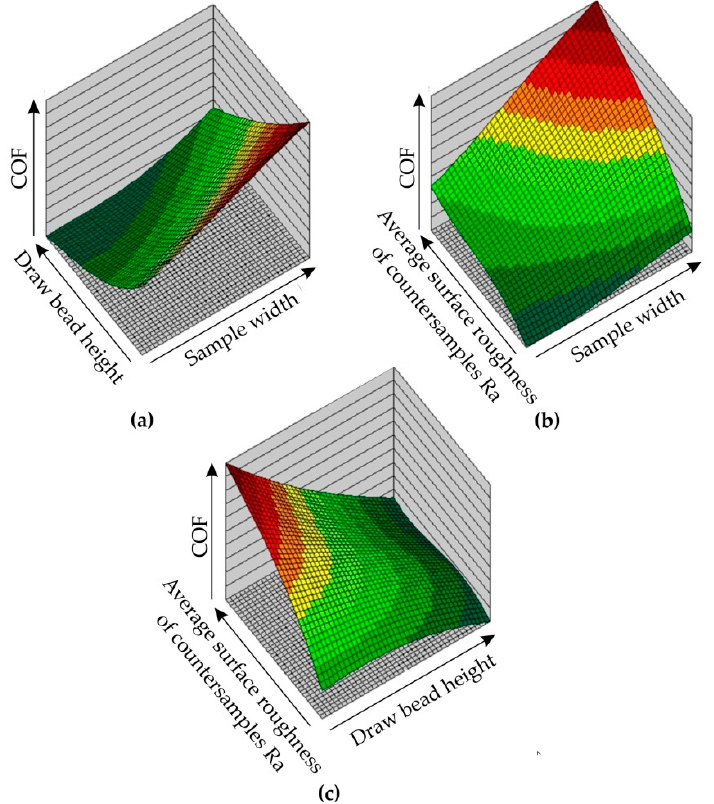
Figure 27. Response surfaces of 5:5-8-1:1 ANN showing the effect of ( a ) sample width and drawbead height, ( b ) sample width and average surface roughness of countersamples Ra, and ( c ) drawbead height and average surface roughness of countersamples Ra on the value of COF.